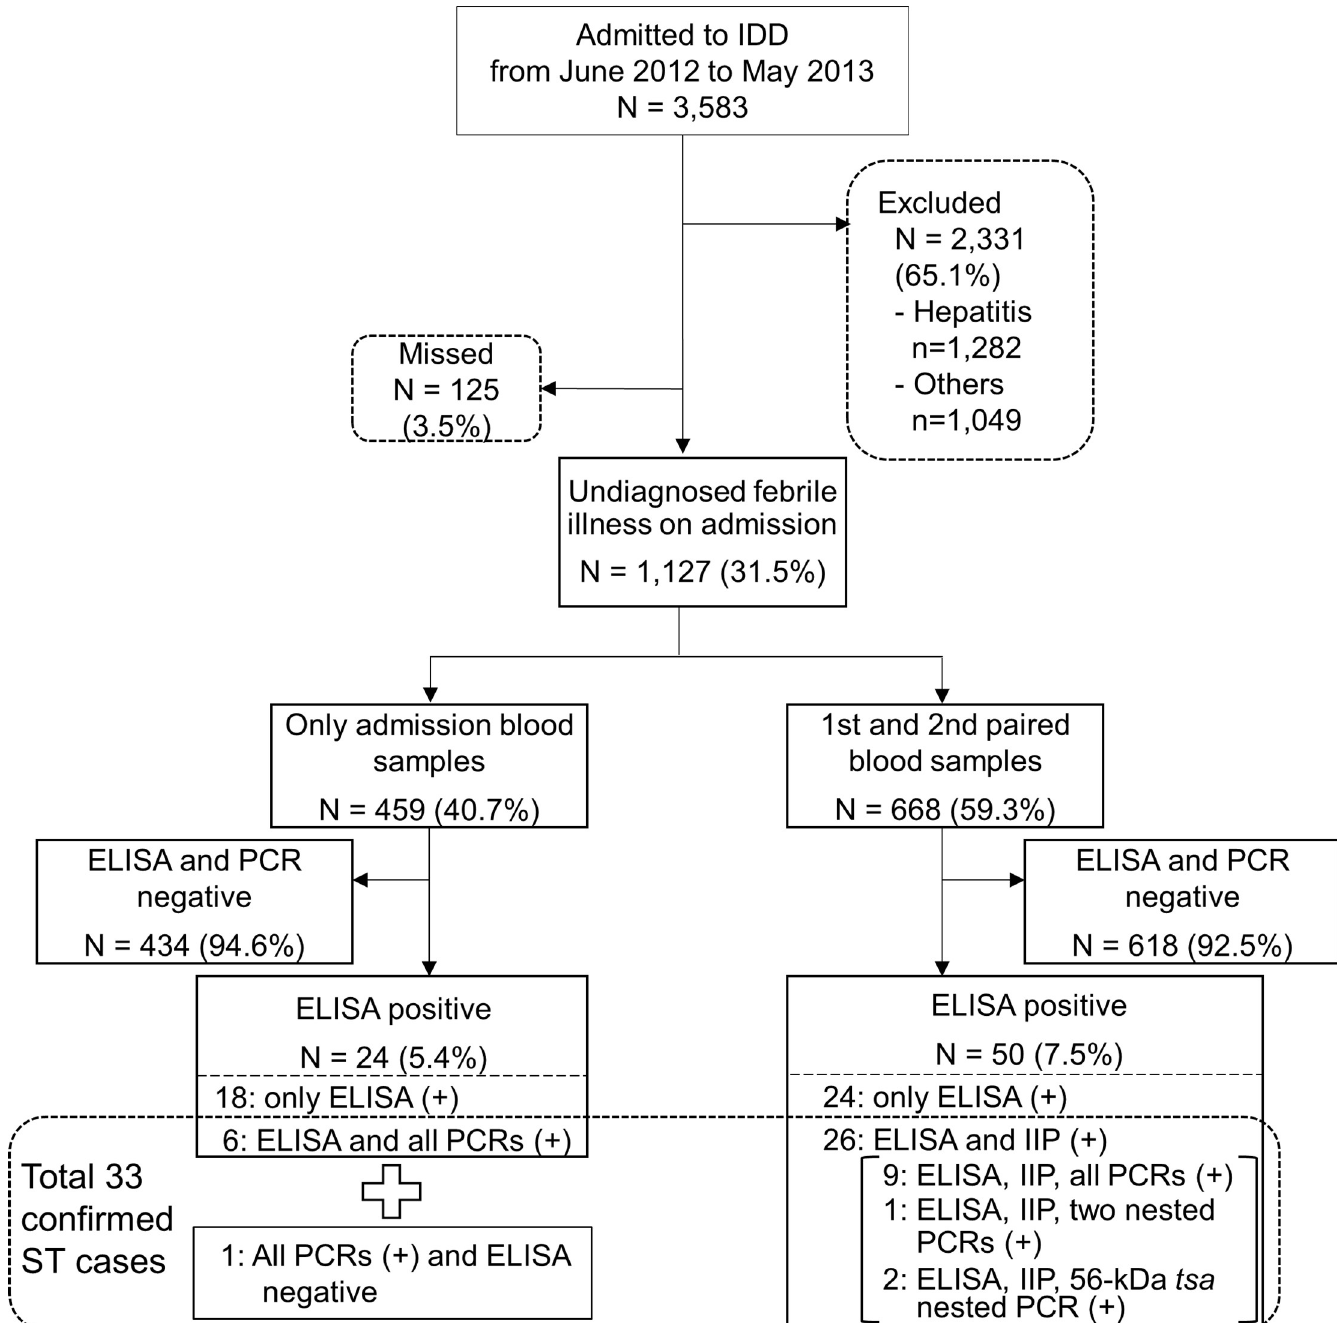
Fig 1. Investigation protocol for patients in the study. IDD: Department of Infectious Diseases, IIP: indirect immunoperoxidase assay, ST: scrub typhus, (+): positive test result. https://doi.org/10.1371/journal.pntd.0007928.g001 with data available) and from fever onset to second blood collection were 14 (10–24, n = 665 with data available), respectively. Fifty of the 668 patients with paired blood samples were screened positive by ELISA, and further tested by IIP. Twenty-six of the 50 ELISA-positive patients with paired blood samples were diagnosed with ST by IIP. Among the patients with